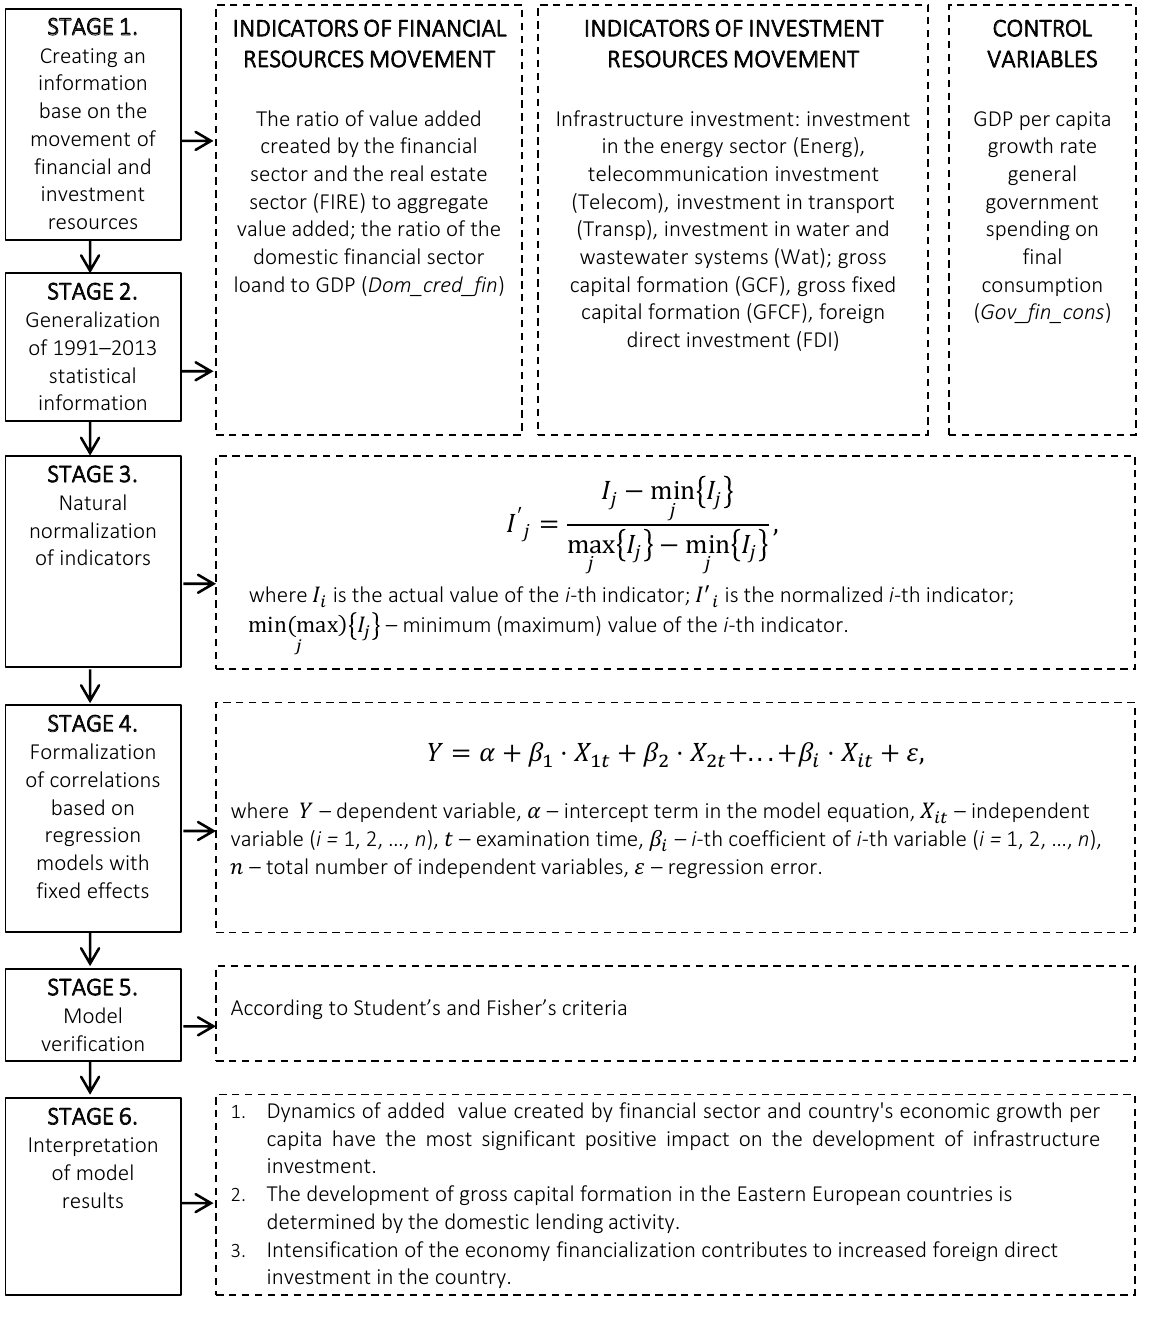
Figure 1. Algorithm for identifying special aspects of the investment flows influenced by